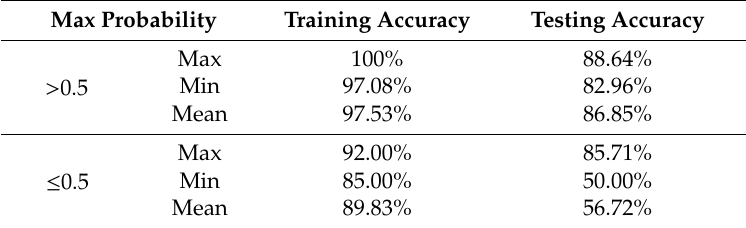
Table 8. Accuracy of max probability > 0.5 and max probability ≤ 0.5 samples.